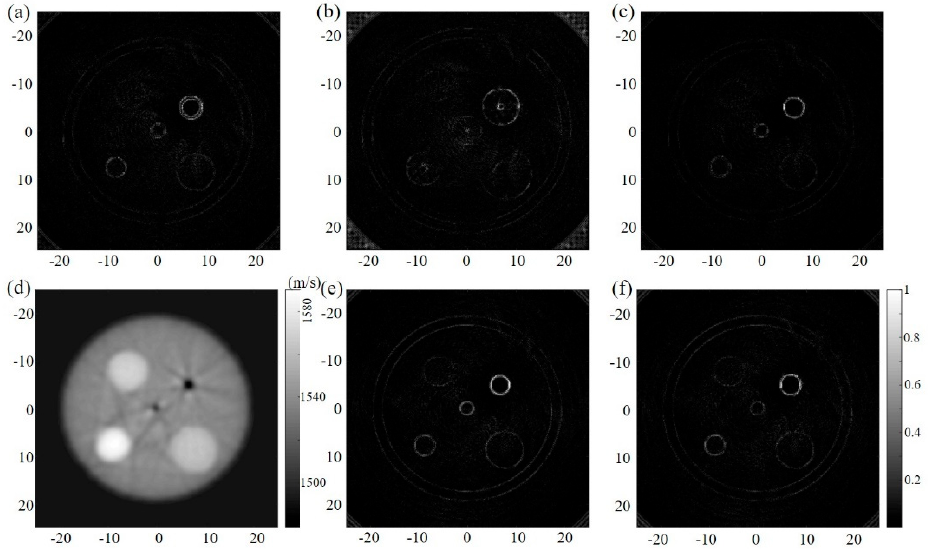
Figure 3. Simulation results. The reflection image from the constant acoustic speed ( a ) 1490 m/s, ( b ) 1540 m/s, and ( c ) 1505 m/s. SoS map derived from the transmission USCT ( d ) and corresponding re fl ection image ( f ). ( e ) Re fl ection image in USCT adapted with the preset SoS map.